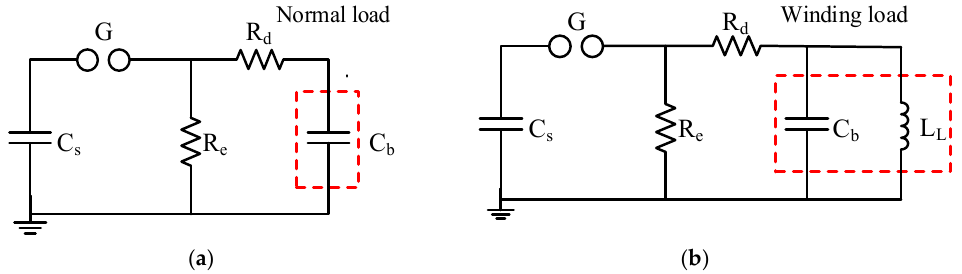
Figure 1. Conventional Marx’s circuit with different loads for generation of impulse voltage; ( a ) normal load; and ( b ) winding load.